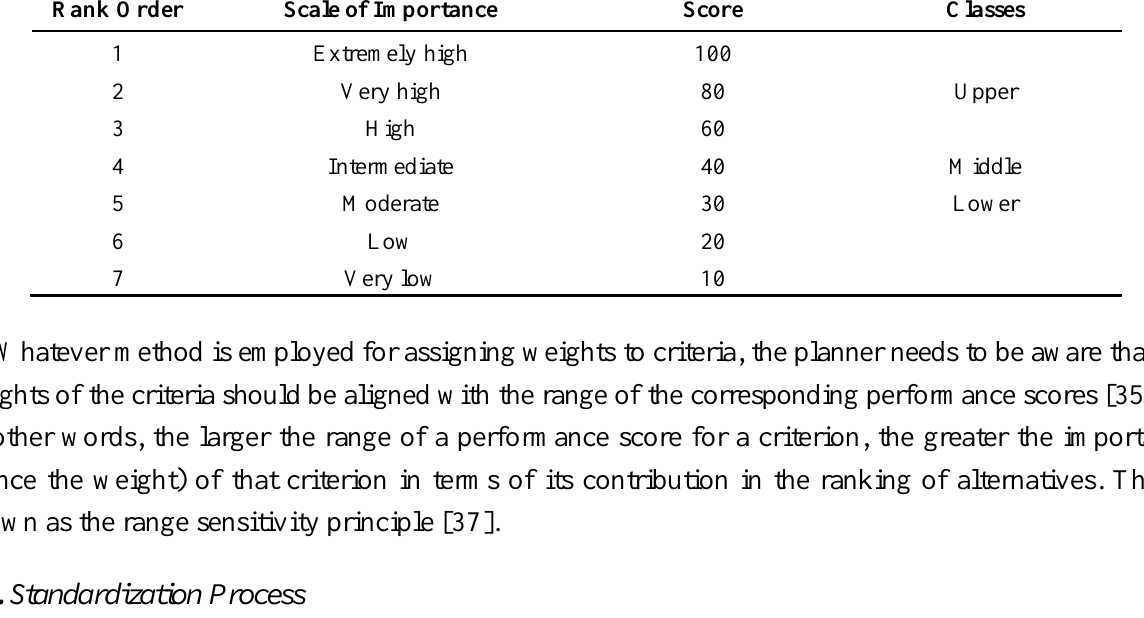
Table 2. The scale of importance and the relevant scores utilized by the qualitative rating method. Rank Order Scale of Importance